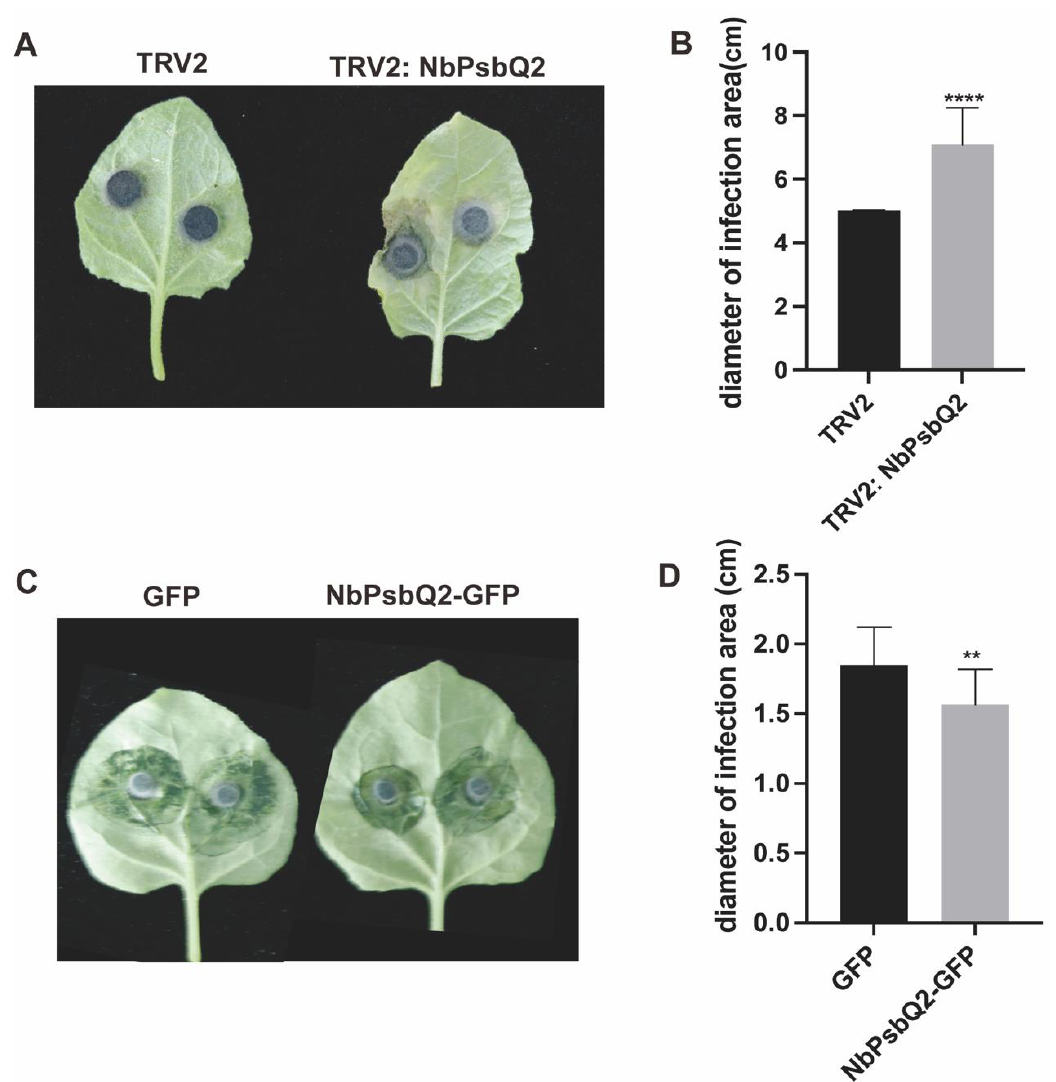
Figure 4. NbPsbQ2 promotes N. benthamiana immunity to L. theobromae . ( A ) Transiently expressed NbPsbQ2-GFP and GFP in N. benthamiana showed promotion of plant immunity to L. theobromae . Images were taken at 4 dpi. ( B ) Diameters of the infection area. Values are the means of 20 biological replicates. Significant differences were evaluated using a t -test and the least significant differences using an (LSD) test (** α = 0.01; **** α = 0.0001). ( C ) Transient expression of NbPsbQ2-GFP and GFP in N. benthamiana promoted plant immunity to L. theobromae. Images were taken at 4 dpi. ( D ) Diameters of the infection area. The values are the means of three biological replicates. Significant differences were evaluated using a t -test and the least significant differences using (LSD) test (** α = 0.01; **** α = 0.0001).